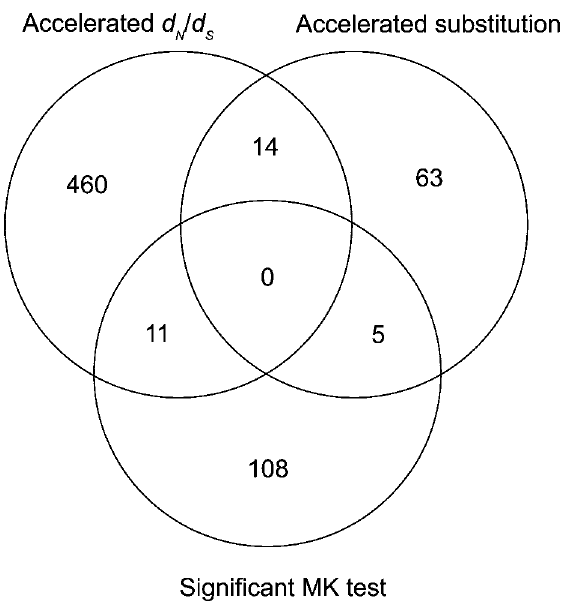
Figure 5. Venn Diagram Showing Overlap between Three Different Subsets of Fast-Evolving Genes Genes with evidence for accelerated d N /d S on the human lineage based on a LRT p , 0.05 using a chi-squared test are shown in one circle. Genes containing exons with evidence for accelerated evolutionary rate in humans based on simulations with a FDR p , 0.05 are in the second circle. Genes with evidence for a significant McDonald-Kreitman test [39] with p , 0.05 are in the third